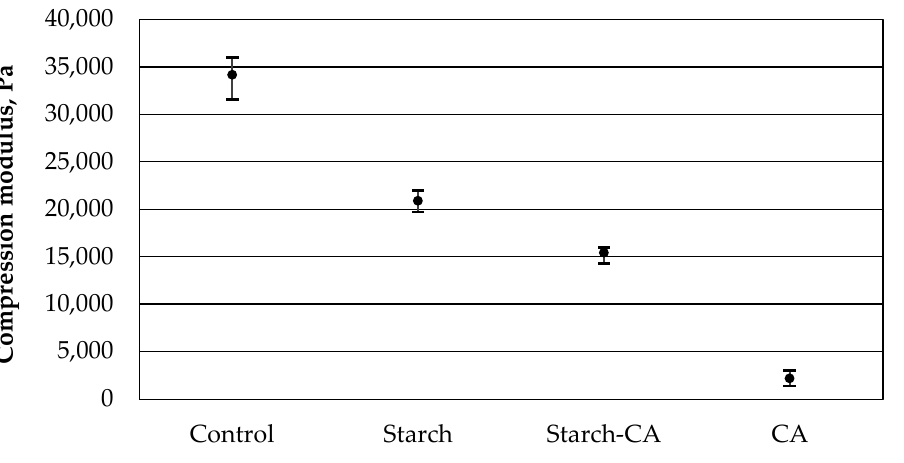
Figure 4. Microscopic structure of the aerogels with a different cross-linkers (left photo shows the overview before modification with MTMS and the right photo show a detail in 10-fold-higher mag- nification than the left photo after modification with MTMS): ( a ) polyester resin (control), ( b ) cellu- lose acetate, ( c ) starch and ( d ) starch–cellulose acetate.